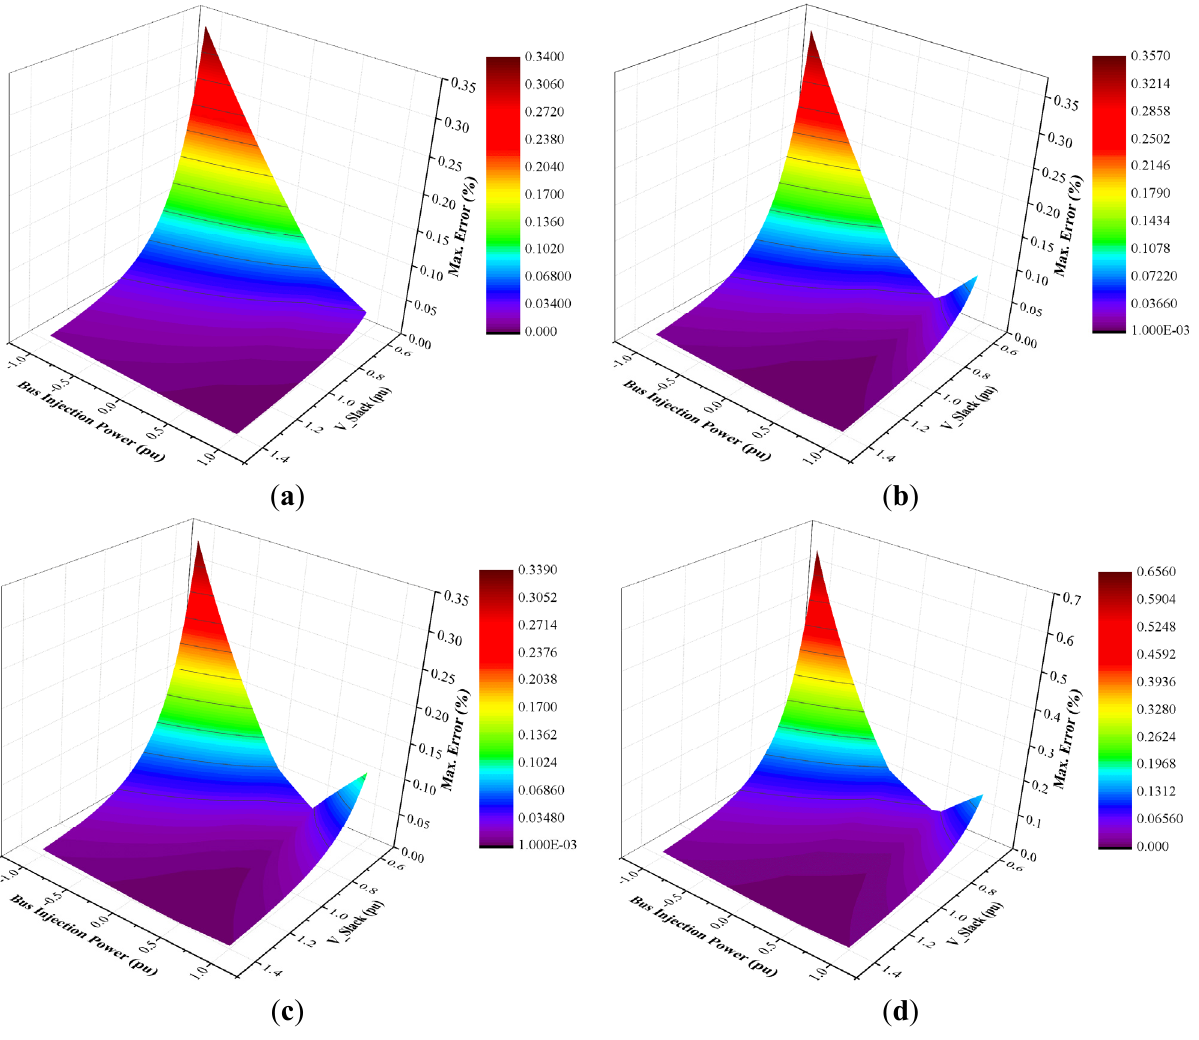
Figure 4. The maximum error in the approximate expression for voltage sensitivity as a function of V slack . ( a ) Injected power varied at bus 2; ( b ) Injected power varied at bus 7; ( c ) Injected power varied at bus 9; ( d ) Injected power varied at bus